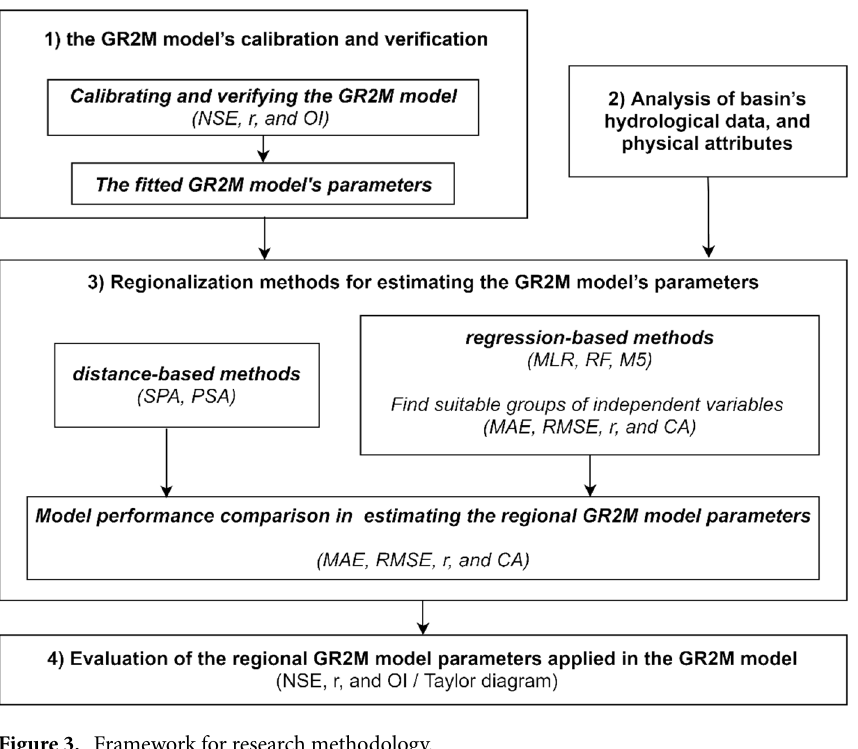
Figure 3. Framework for research